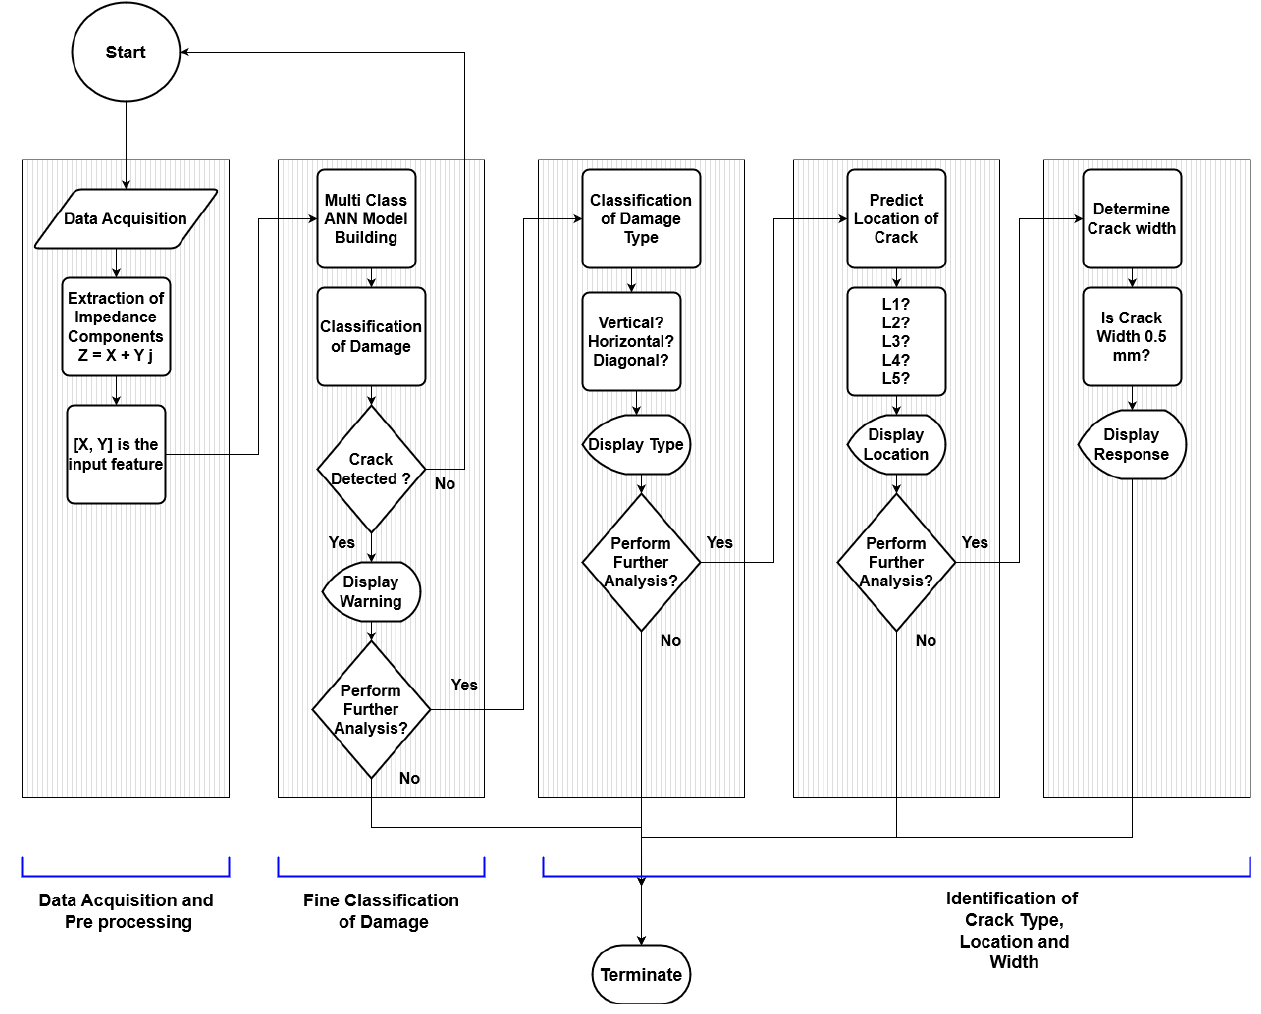
Figure 3. Flowchart of the Machine Learning classification methodology.